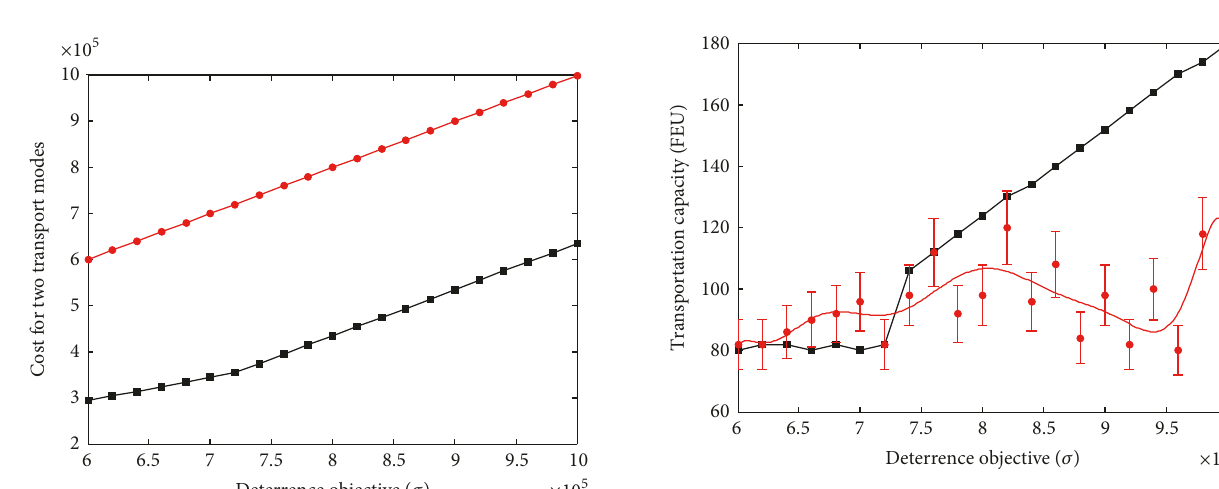
Figure 7: The transportation capacity for two carriers varying with the deterrence objective. Black square for carrier 1 (shipping); red circle for carrier 2 (railway).